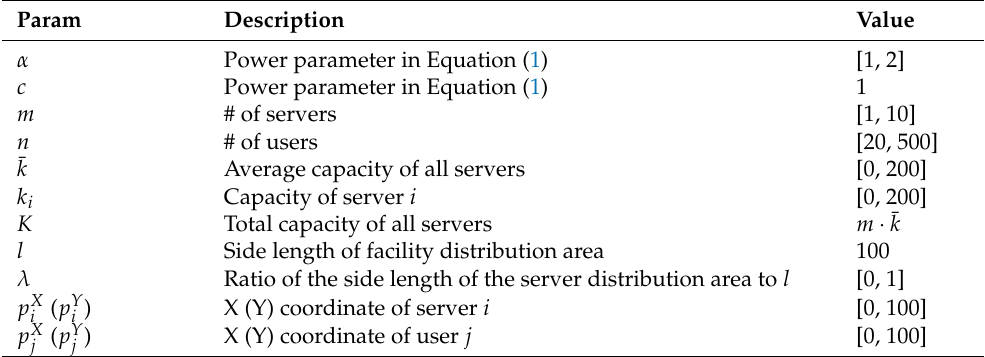
Table 2. Configuration of experimental parameters.